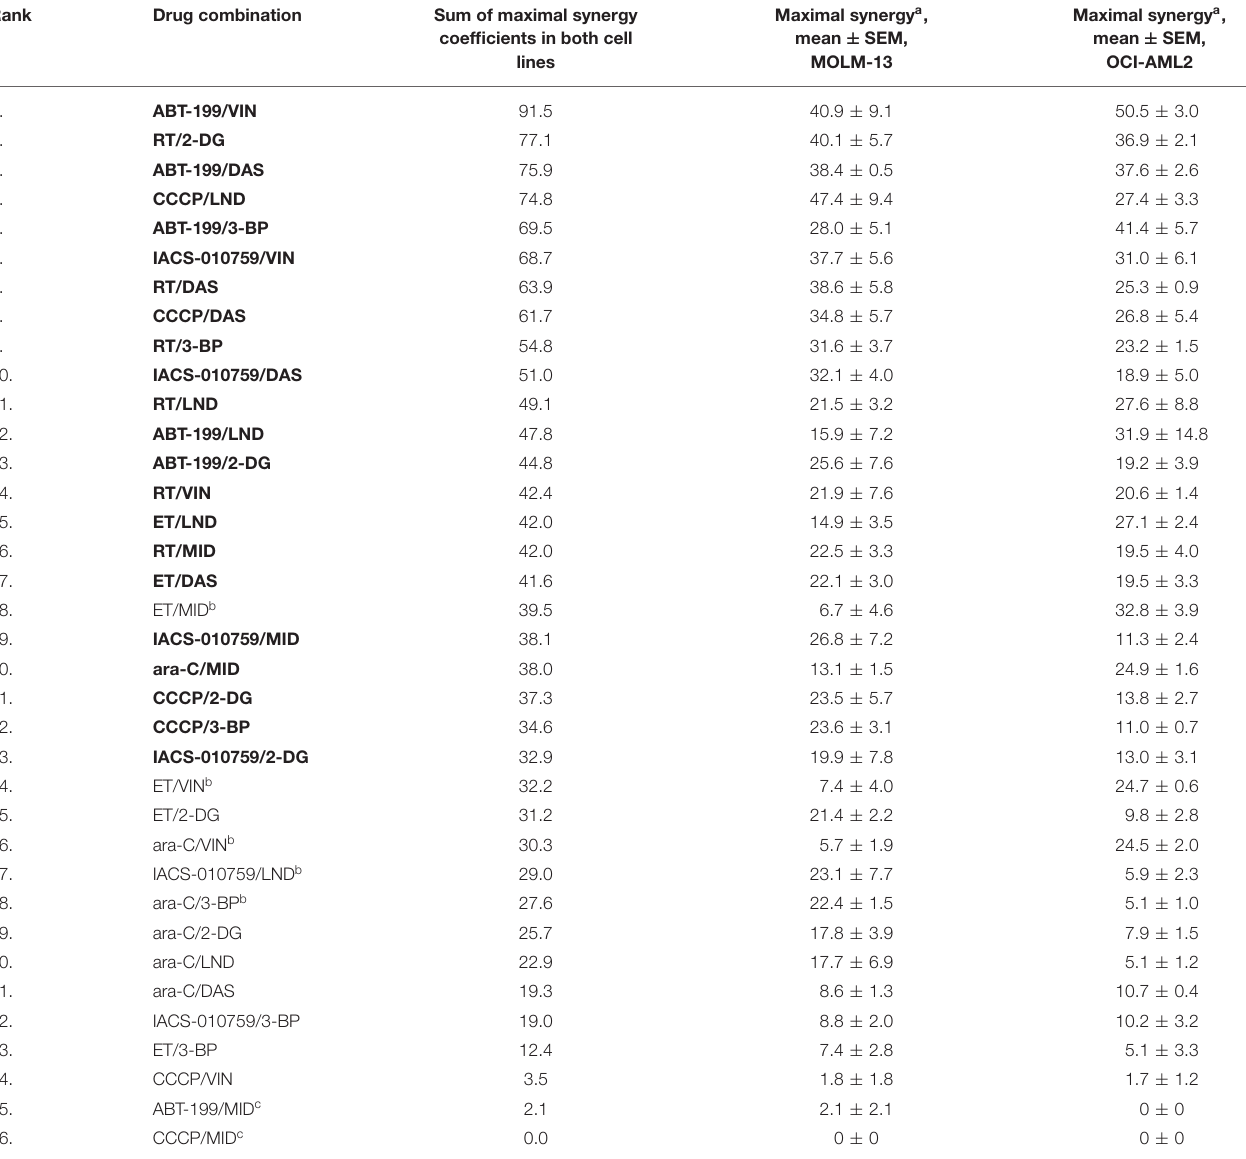
TABLE 1 | Mitocan-based drug combinations ranked in order of decreasing combined synergy coefficient. Rank Drug